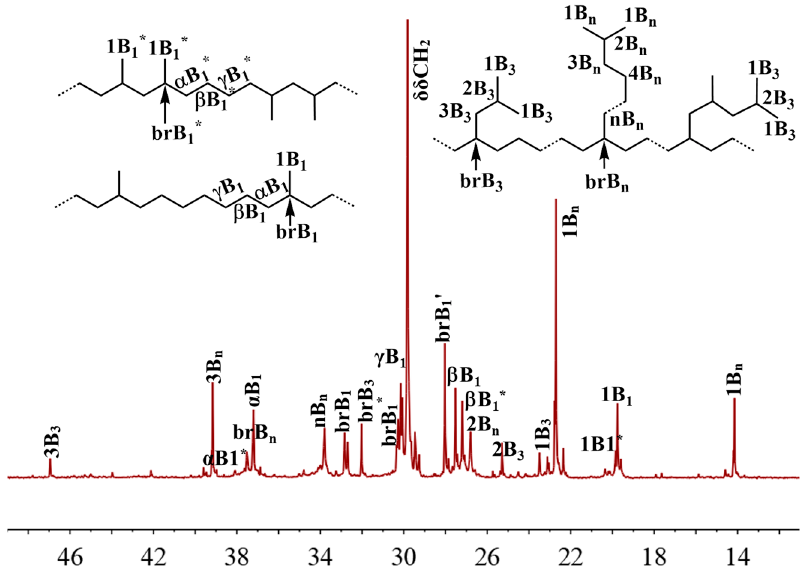
Figure 3. 13 C NMR spectrum analysis of the partially chain-straightened propylene oligomer ob- tained by using Pd3 at 30 o C (Table 1, entry 5). x is the carbon, starting from the methyl end with 1. The methine groups for the different branch lengths are labeled with brBy. The asterisk represents the situation when the methyl groups are in adjacent positions to each